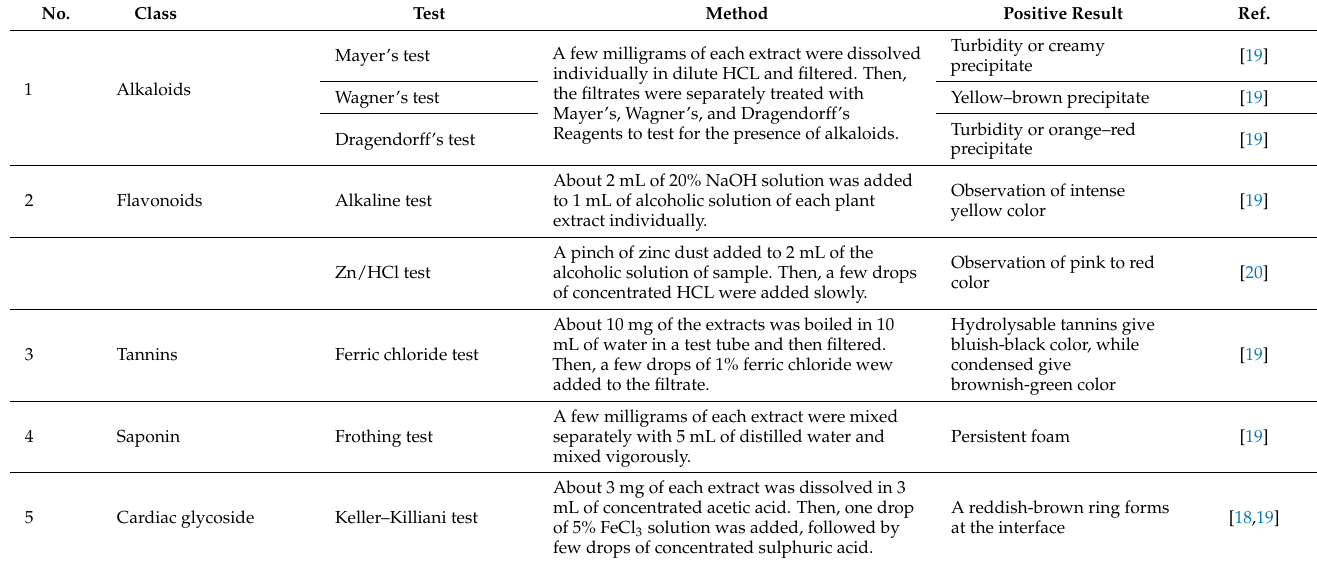
Table 5. Qualitative phytochemical tests used for the screening of Cassia timoriensis